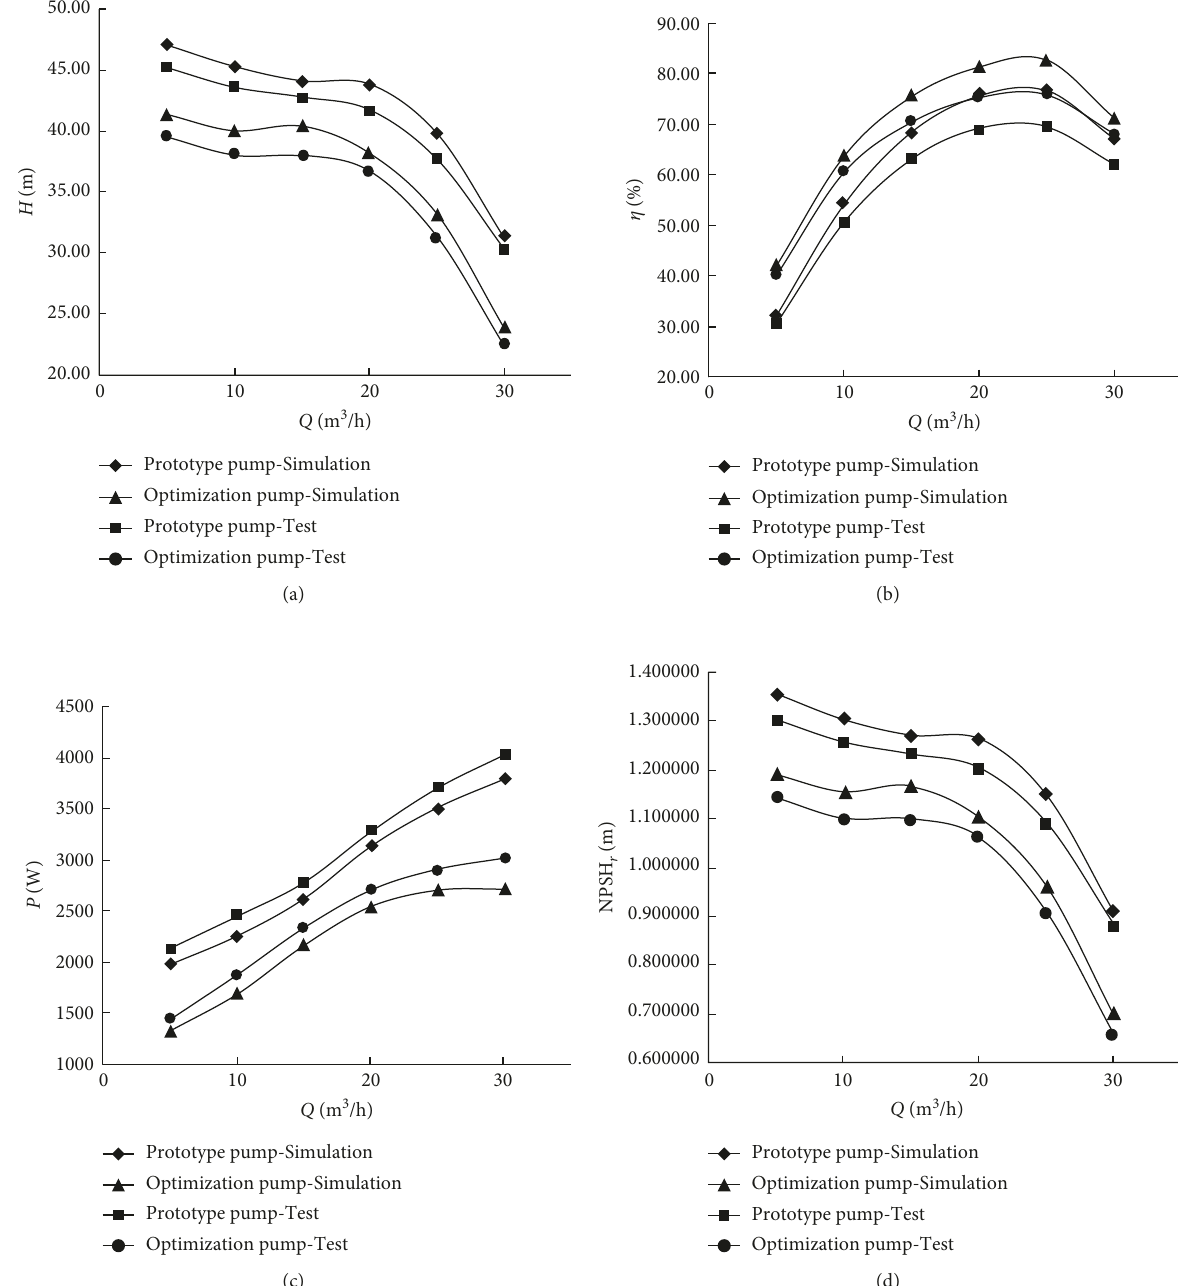
Figure 7: Comparison of external characteristics of optimization pump and prototype pump. (a) H − Q . (b) η − Q . (c) P − Q . (d) NPSH